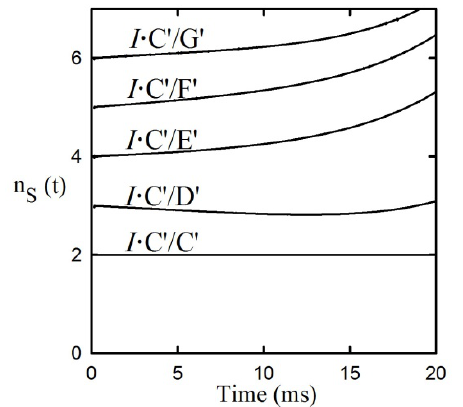
Figure 4. The second rule time course of the first derivatives of the tKIEs applied to the mechanism portrayed in Scheme 1. I is set to a value of 2 here as required by the location of the iss in this